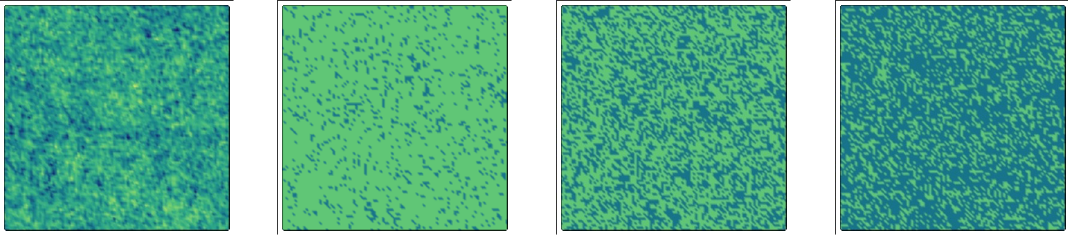
remains the same order of magnitude. This 2